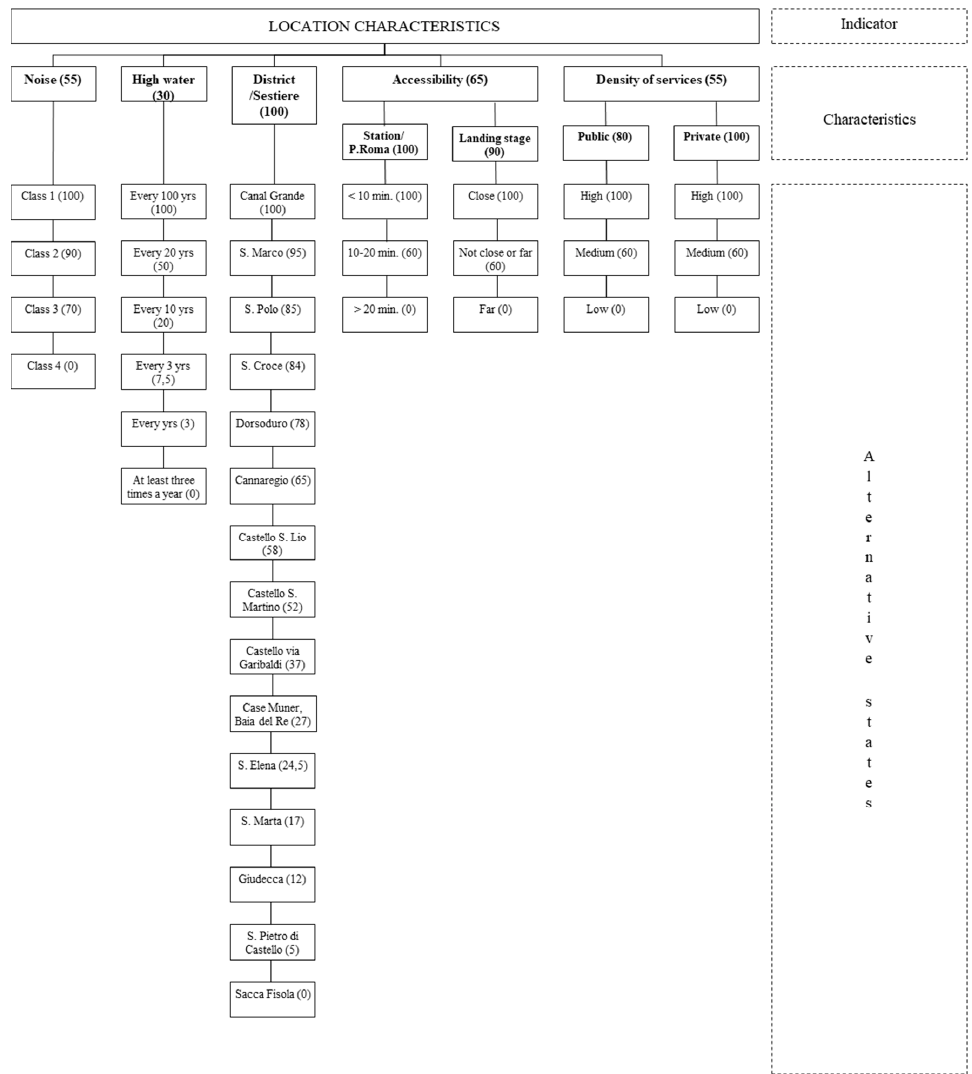
Figure 3. The structure of the “location” indicator ( c l ).